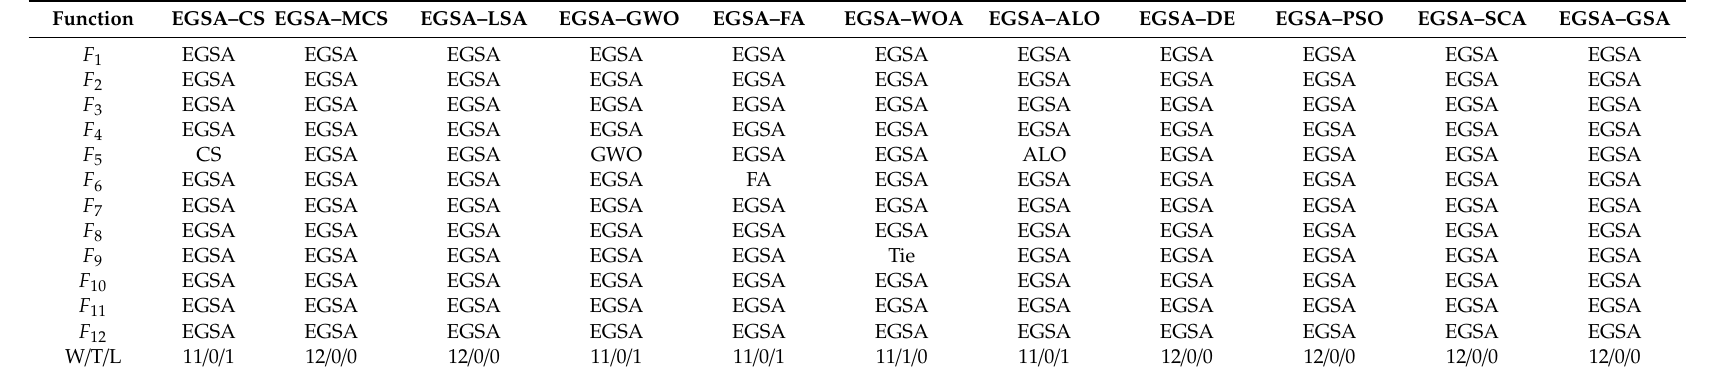
Table 3. The results of Wilcoxon test for a single problem for statistical significance level at alpha = 0.05.